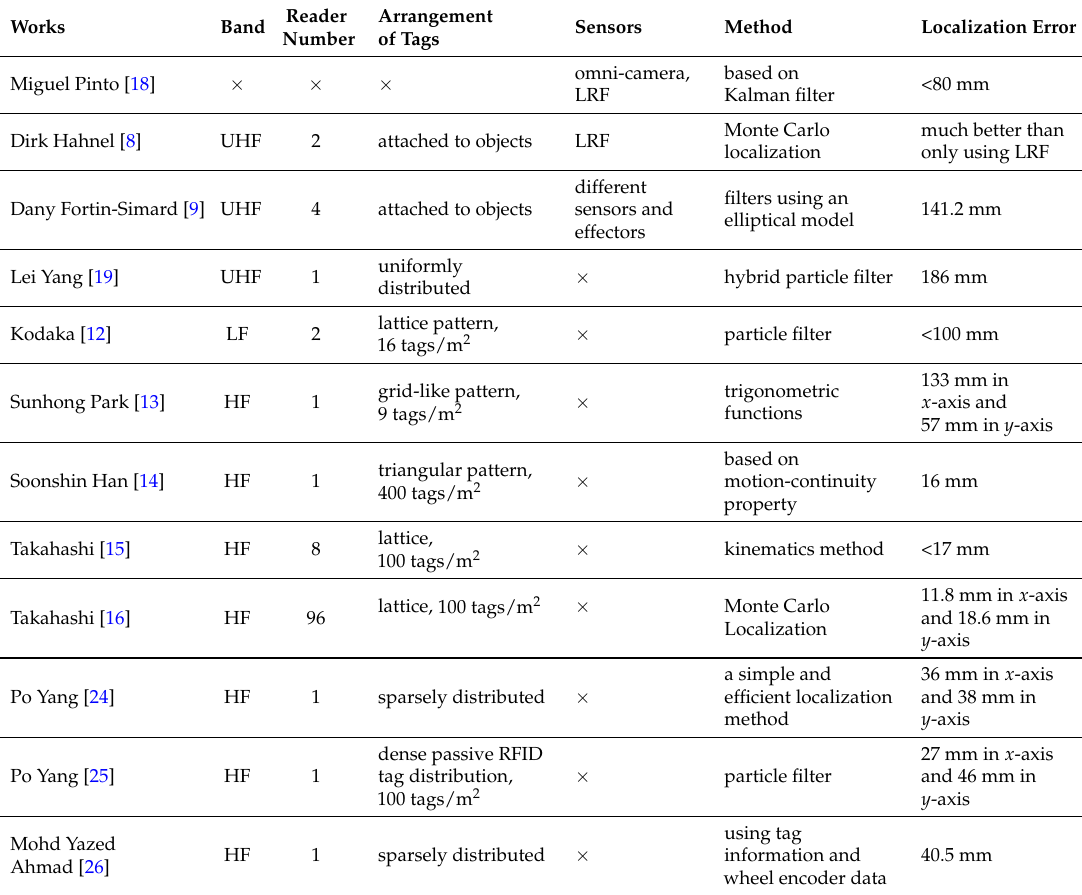
Table 1. Related works: